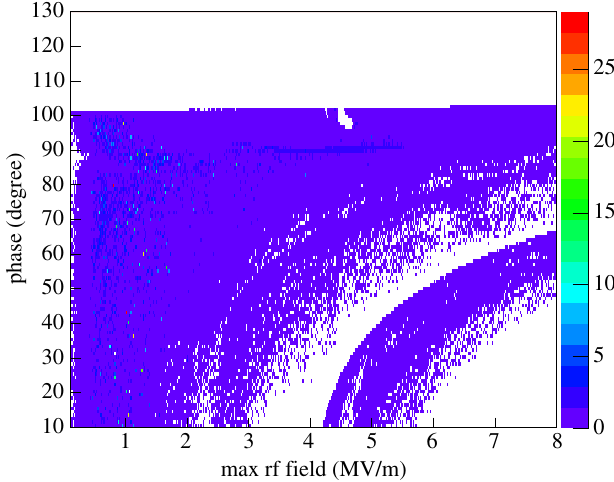
FIG. 20. (Color) Electron multiplication factor for the FNPL/ TTF1 gun. For this simulation, the currents in the three solenoids were set to be the same value (round beam settings), producing a peak magnetic field of 0.12 T. Primary and secondary electrons were tracked for 100 rf cycles. The white area shows no multi- pacting condition.